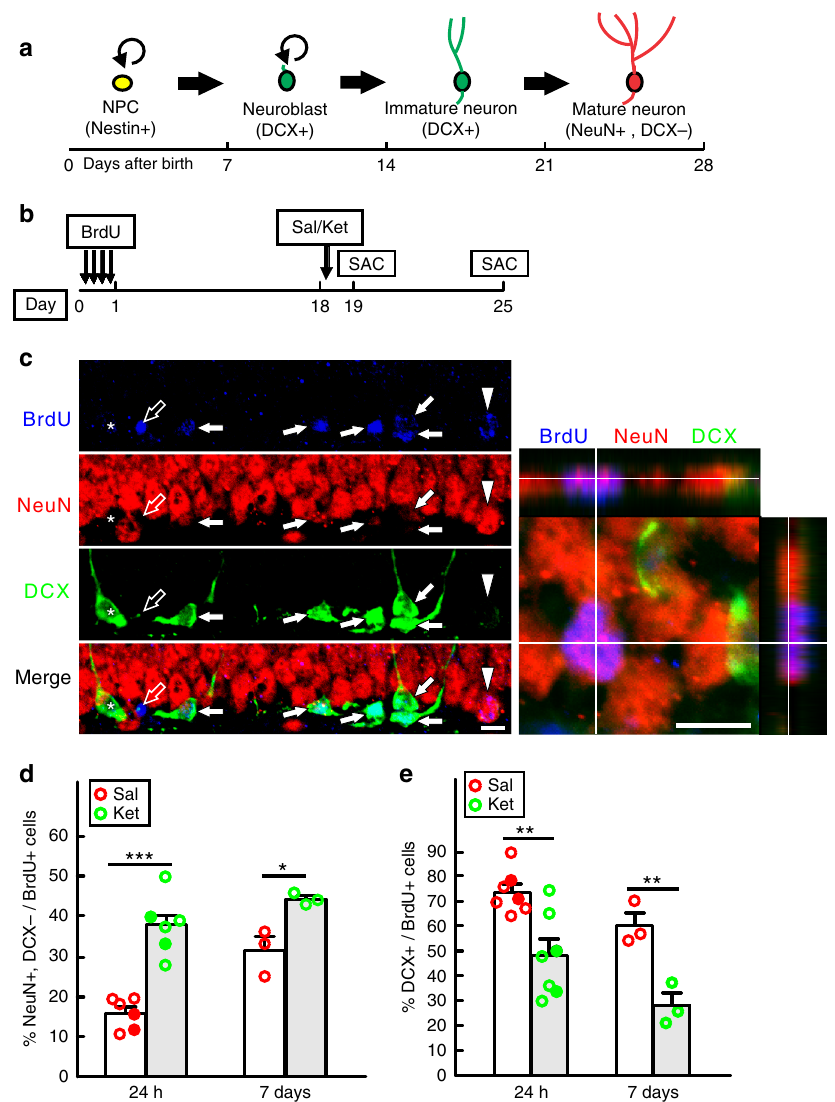
Fig. 1 Ketamine accelerates DCX+ progenitor differentiation into NeuN+ newborn neurons in adult DG. a The estimated timeline for the development stages of adult hippocampal neurogenesis. Within 2 – 3 weeks, newborn radial glia-like neural stem/progenitor cells (NPC) could transiently proliferate, survive and differentiate into doublecortin (DCX) positive neuroblasts and immature neurons, which progress into NeuN positive mature neurons at about 28 days after birth. b Diagram for the analysis of DCX+ cell differentiation in the wild-type (WT) mice. To allow for BrdU to be incorporated in DCX+ cells, BrdU pulses were administered 18 days before saline (Sal) or ketamine (Ket) treatment, and animals were sacri fi ced (SAC) either at 24 h or 7 days after the treatment. c Representative confocal images of the DG show four types of cells: BrdU+ cells (blue) that co-express strong DCX (green, denoted by solid arrows) or NeuN (red, denoted by arrowheads); cells are labeled with BrdU alone (denoted by empty arrow); BrdU unlabeled DCX+ immature neurons (by asterisk). A magni fi ed image of a typical newborn mature neuron (NeuN+/DCX − /BrdU+) in an orthogonal view is shown on the right. Scale bar, 10 µ m for both images. d Quanti fi cation of NeuN+/DCX − cell percentage in total BrdU+ cells at both 24 h and 1 week time points ( n = 6 per group for 24 h and n = 3 per group for 7 days; BrdU-labeled cell number in the DG is 247.5 ± 59.55 vs. 215 ± 38.59 for saline vs ketamine at 24 h; 198.7 ± 12.91 vs. 184.7 ± 31.39 saline vs ketamine at 7 days, respectively; unpaired two-tailed t -test, *** p < 0.0001 for saline vs ketamine at 24 h; * p = 0.0225, saline vs ketamine at 7 days). e Quanti fi cation of DCX+ cell percentage of total BrdU+ cells at both 24 h and 1 week time points ( n = 7 per group at 24 h; n = 3 per group at 7 days; unpaired two-tailed t -test, ** p = 0.0046 for saline vs ketamine at 24 h; ** p = 0.0095, saline vs ketamine at 7 days). Circles in solid